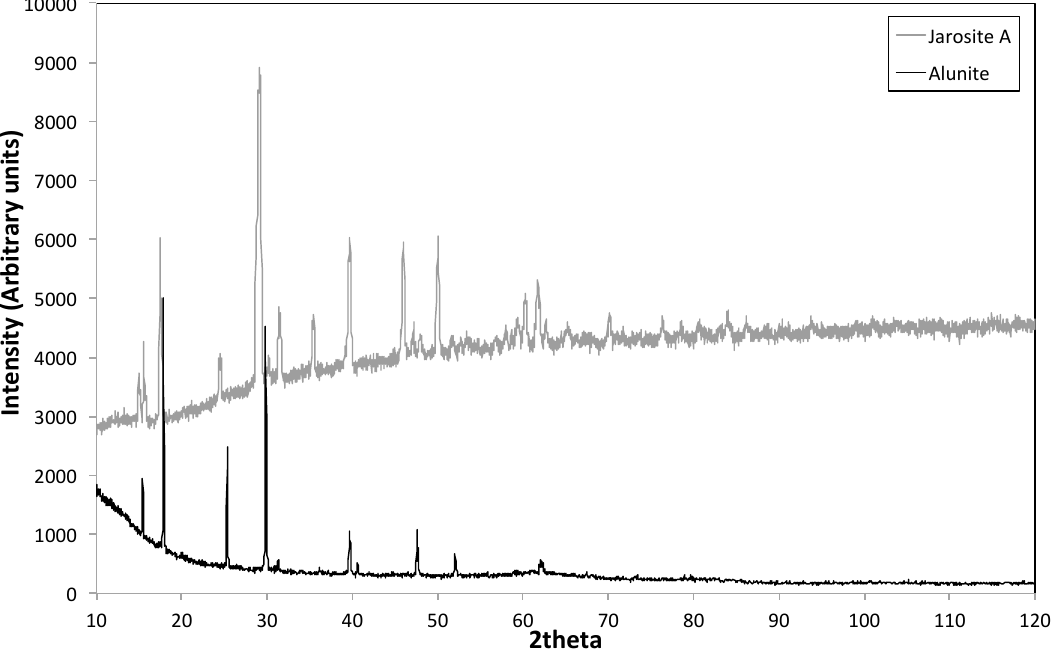
Figure 4. XRD pattern of end member solids, jarosite and alunite.